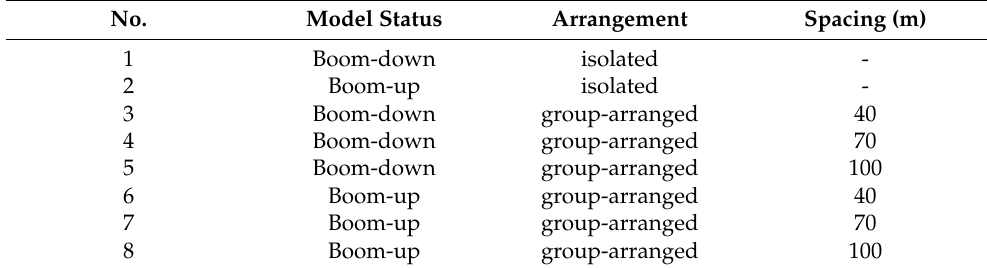
Table 1. Details of the wind tunnel test